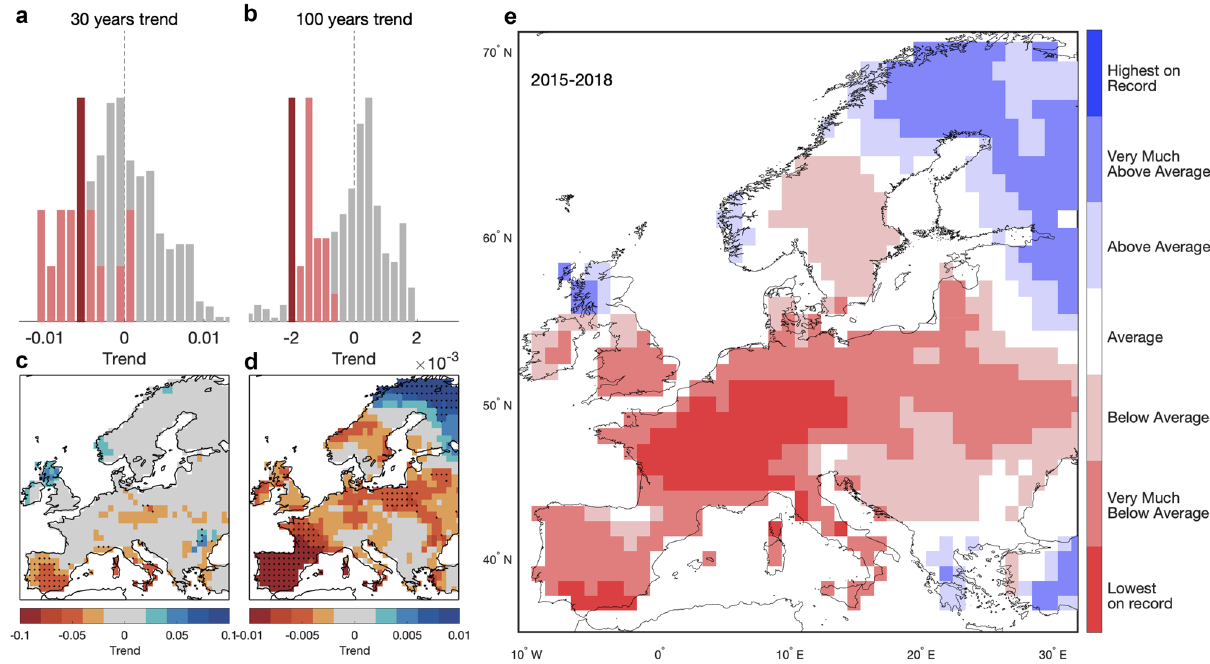
Fig. 4 Recent trends and drought. a , b Contextualising recent 30- and 100-year trends of average European SPEI (JA). Histograms show the full range of the trends (grey shaded bars) prior to 1970 for 30-year periods ( a ) and 1900 for 100-year periods ( b ). Recent periods are shown in light red, except the most recent period, which is shown in dark red. Bar heights are normalised by the maximum occurrence. c , d Recent trends of gridded SPEI of the most recent 30-year period ( c ) and 100-year period ( d ) ending in 2018. Stippling indicates statistically signi fi cant trends ( p < 0.05). e The recent drought